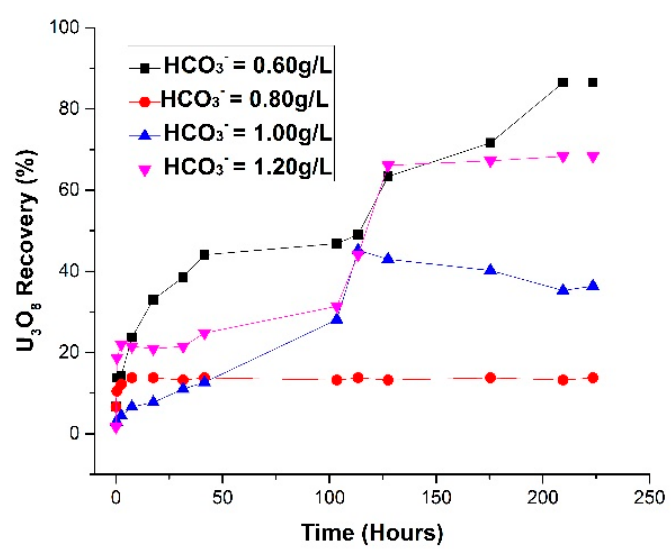
Figure 5. Change in uranium recovery in the leaching solution. Table 8. Geochemical analysis of ore and residues.